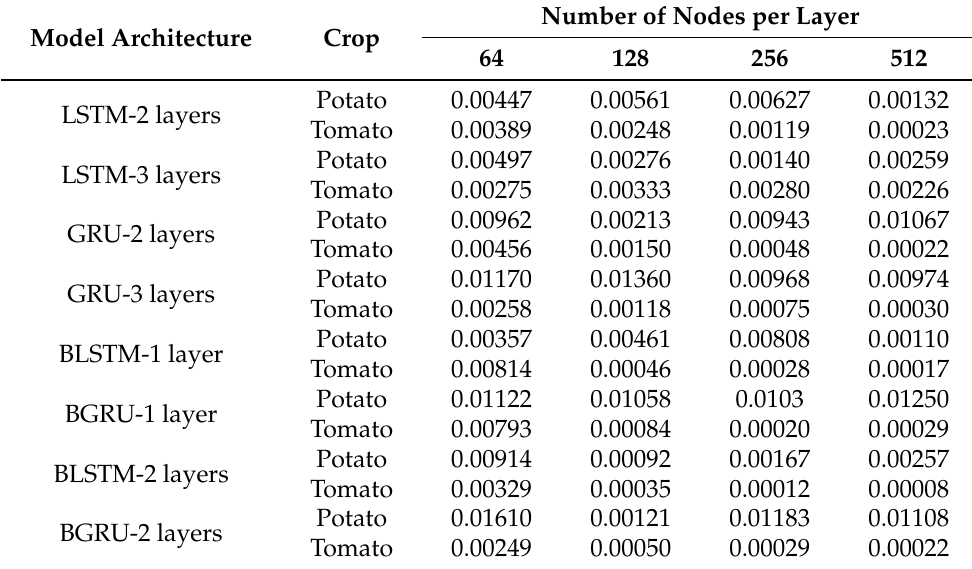
Table 4. Validation MSE for different numbers of LSTM layers and LSTM nodes per layer.